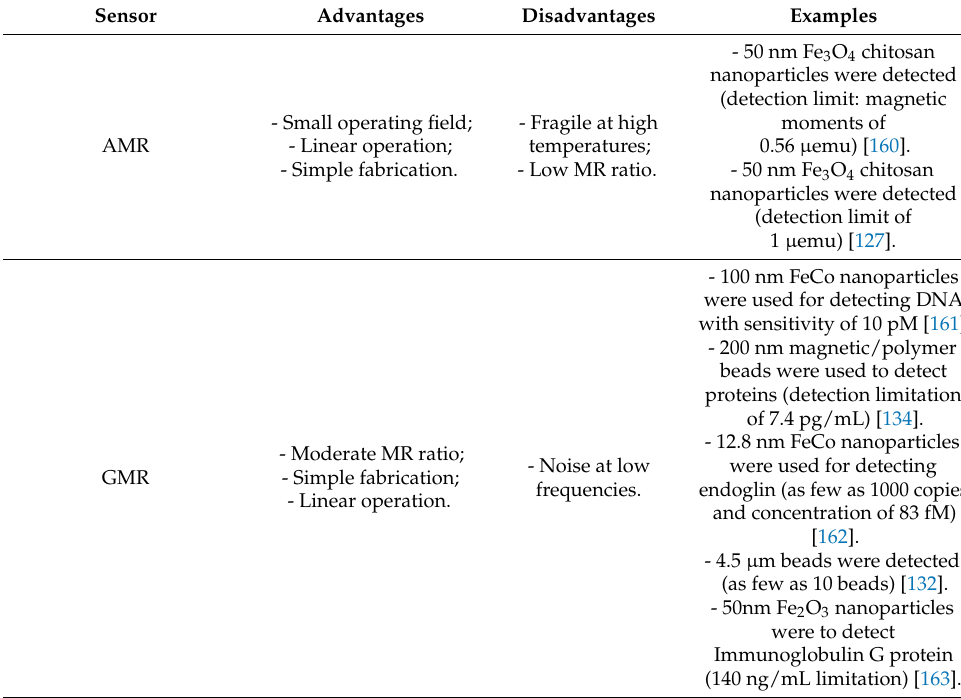
Table 4 tabulates the advantages and disadvantages of various sensor types together with some examples. Table 4. Advantages and disadvantages of multiple magnetic